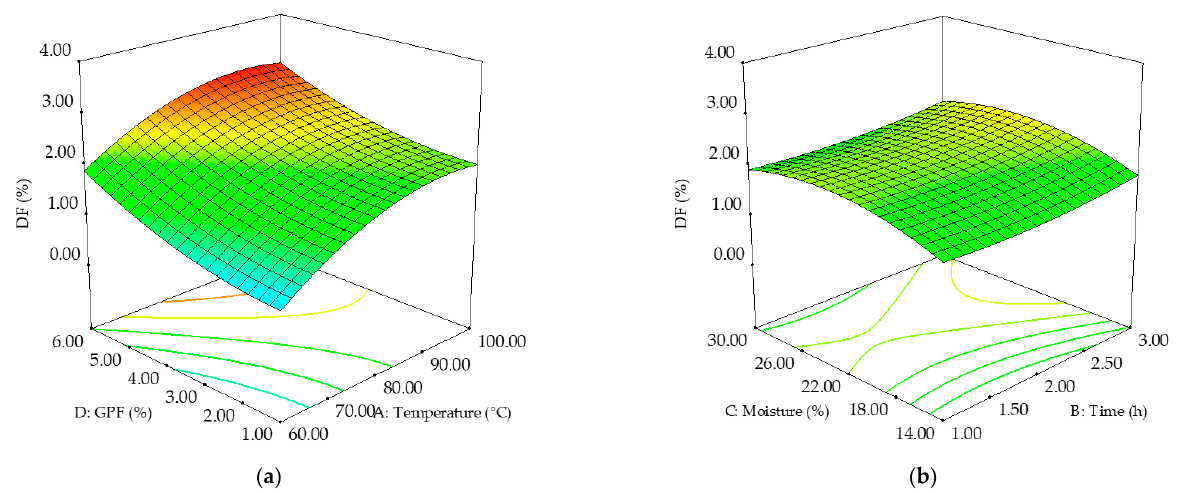
Figure 5. Three-dimensional response surface plots presenting the synergistic effects of factors: GPF level–temperature ( a ) and moisture-time ( b ) on dietary fiber content